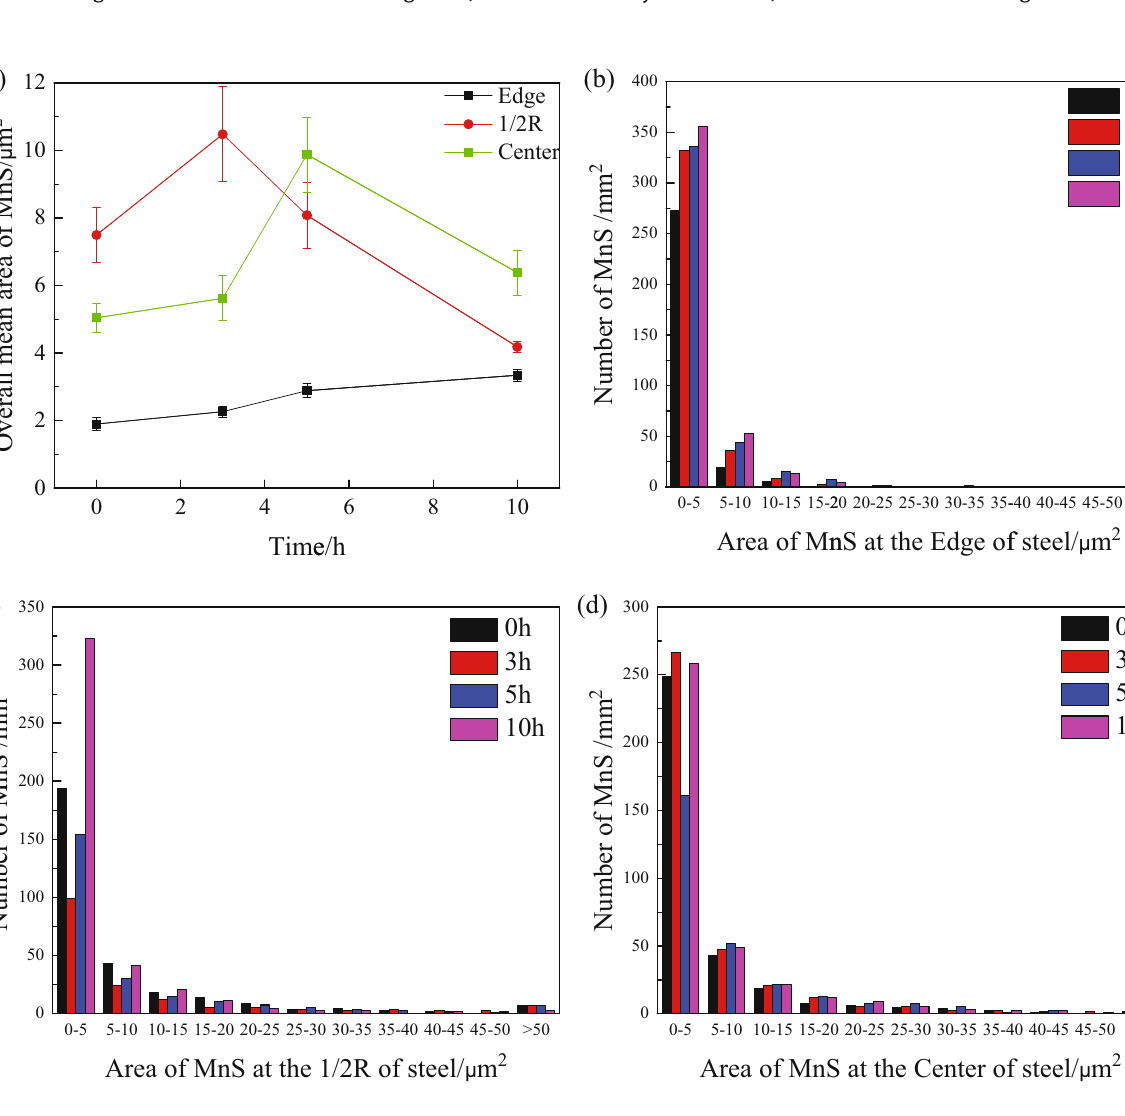
Figure 6: Overall mean area and area distribution of MnS at different positions without and with homogenization at 1,250°C; ( a ) overall mean area of MnS, ( b – d ) area distribution of MnS at the edge, 1/2R and center,